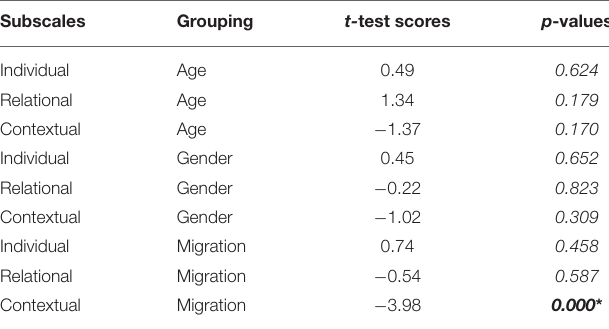
TABLE 3 | T -tests on the three subscale scores by age, gender, and migration background.